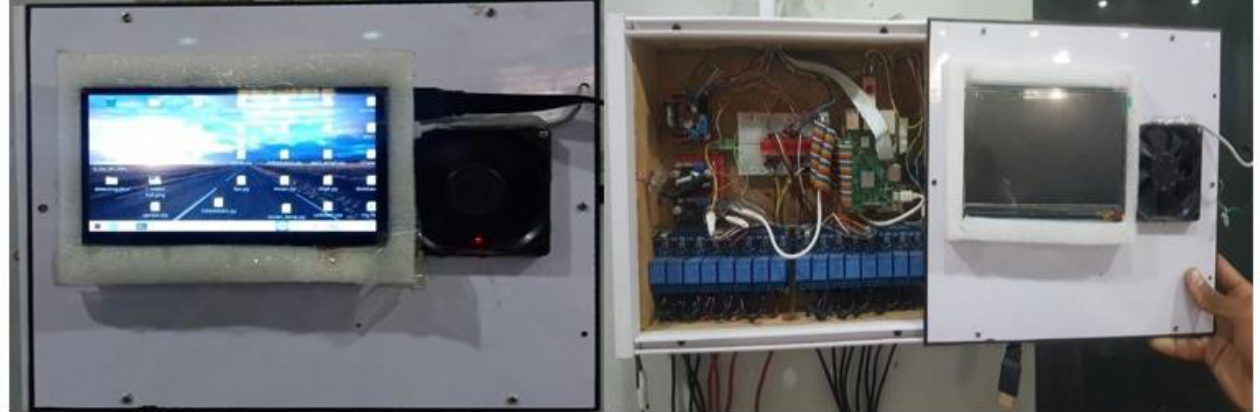
Figure 9. The main electric board of our proposed system.